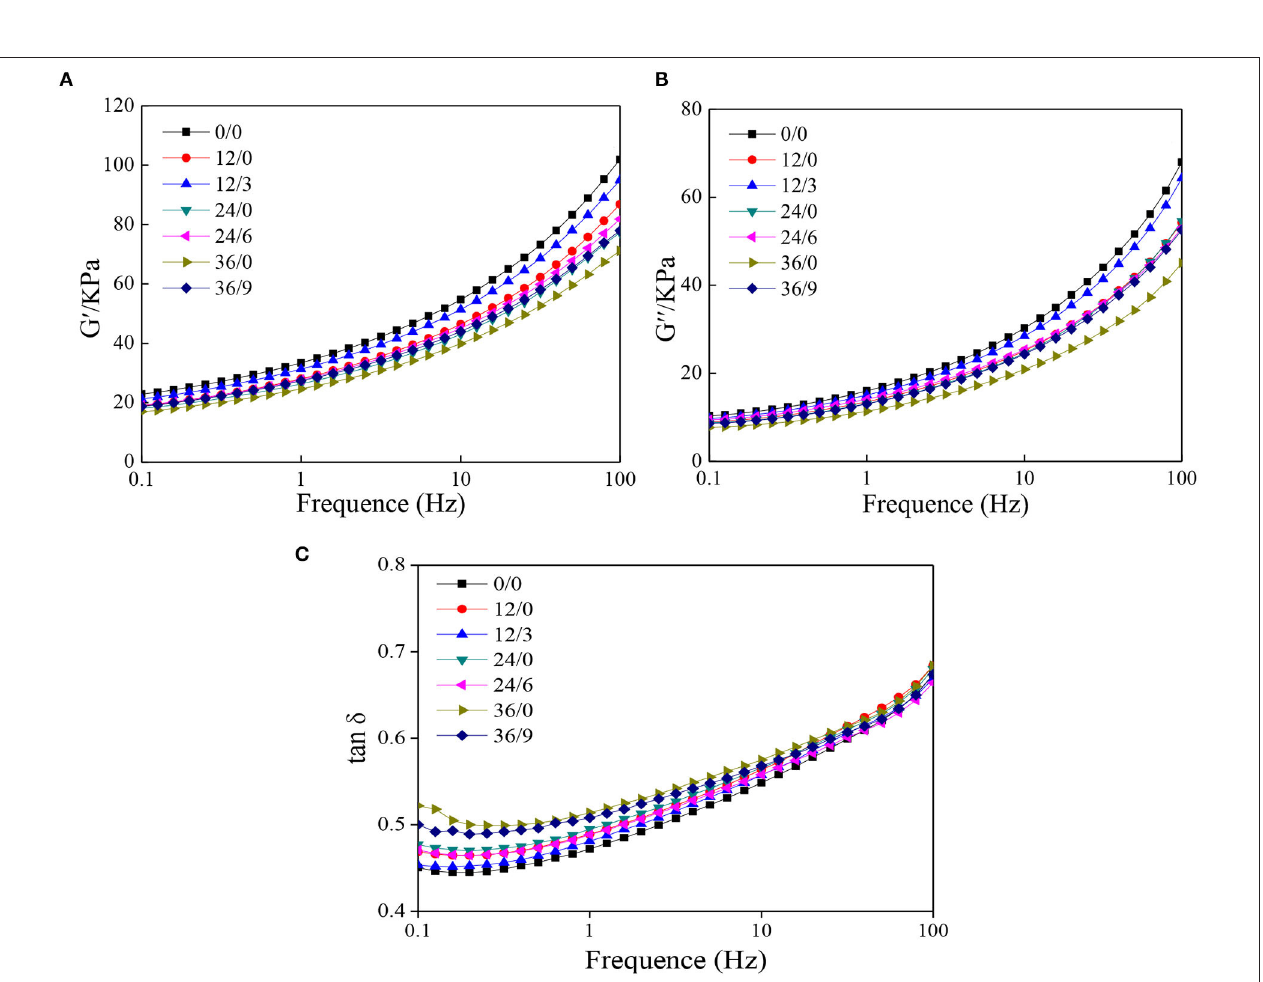
FIGURE 7 | The dynamic rheological properties of whole wheat dough during germination under UV-B radiation. (A) storage modulus (G ′ ); (B) loss modulus (G"); and (C) loss tangent (tan δ ).